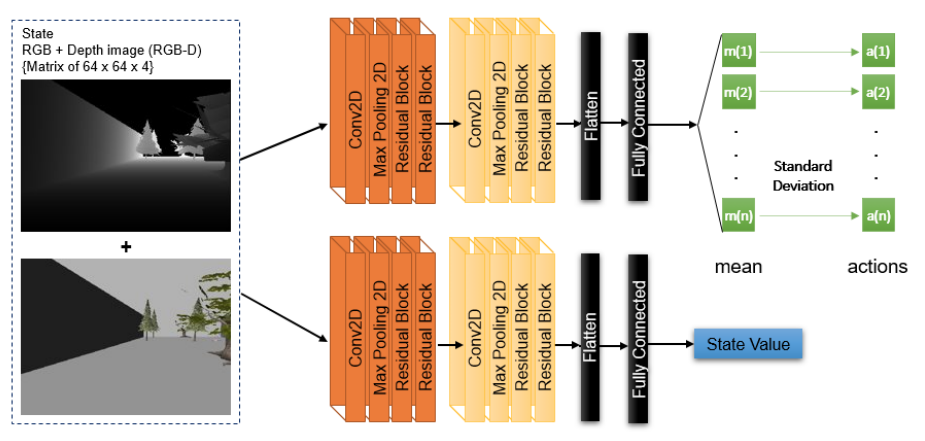
Figure 2. This diagram shows neural networks used for the policy and value network of the SCAN